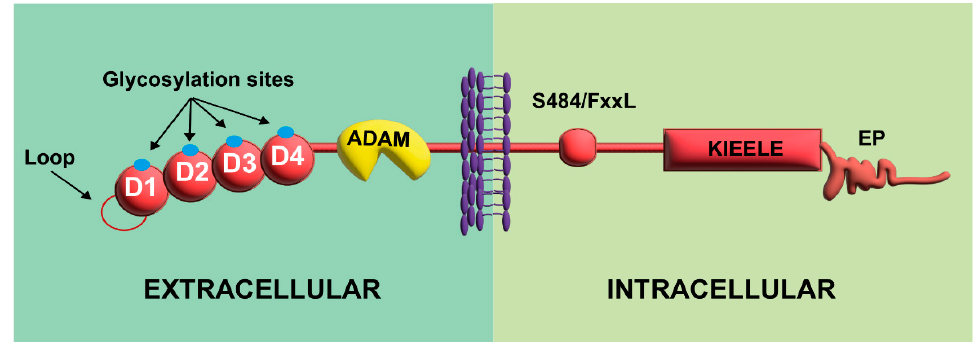
Figure 1. Extracellular and intracellular structure of LAG-3. The receptor LAG-3 comprises four extracellular domains, D1–D4, with D4 located closer to the extracellular membrane and D1 more distal. Additionally, the extracellular domains possess multiple glycosylation sites and a loop in D1 that promotes interaction with MHC-II. An extracellular domain can undergo proteolytic cleavage by ADAM. The intracellular domain contains a serine phosphorylation site (S484/FxxL motif), a unique amino acid sequence (KIEELE), and a glutamic acid and EP repeat.